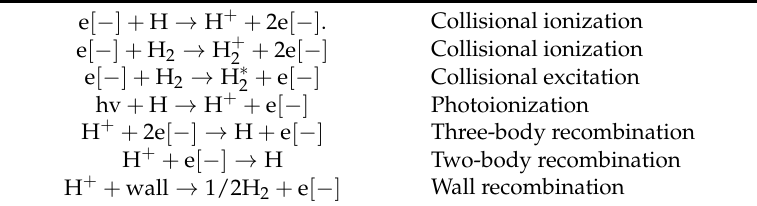
Table 1. Ionization and recombination of hydrogen atom [24,29–31]